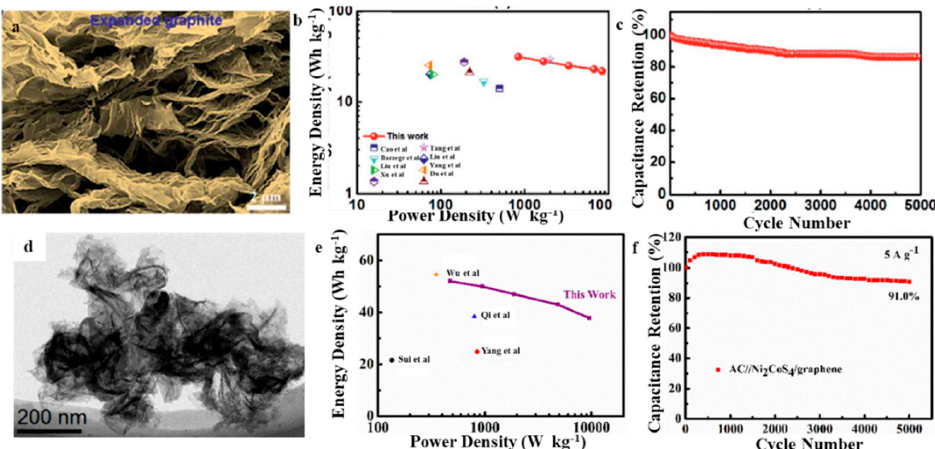
Figure 8. ( a ) SEM of EG [67]; ( d ) TEM of Ni 2 CoS 4 /EG [68]; Ragone plots of volume power density versus energy density for ( b ) EG [67]; ( e ) Ni 2 CoS 4 /EG [68]; Cycling performance of ( c ) EG [67]; ( f ) Ni 2 CoS 4 /EG [68]. Reprinted with permission from Reference [67]. Copyright 2018 RSC. Reprinted with permission from Reference [68]. Copyright 2019 Table 2. Summary of asymmetric supercapacitor using EG-based materials as electrode materials.